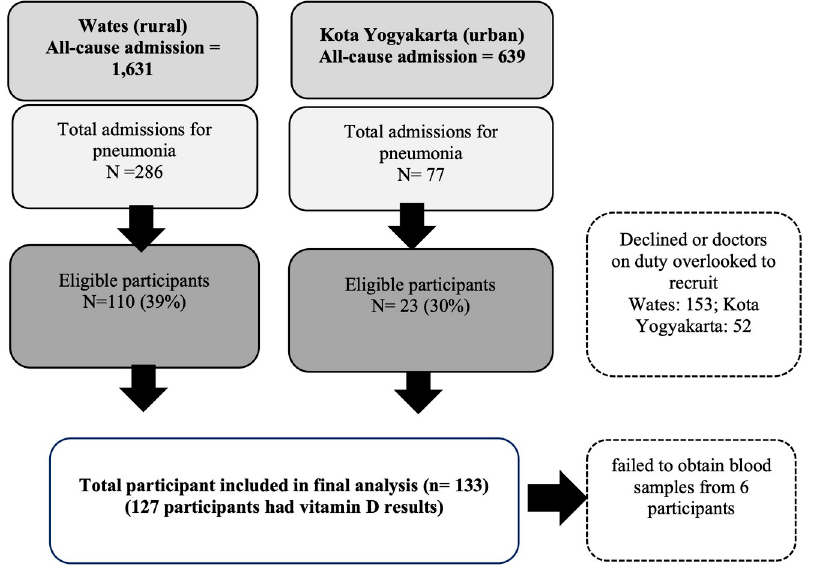
Fig 1. Hospital study recruitment between the 1st February 2016 to 31th July 2017.